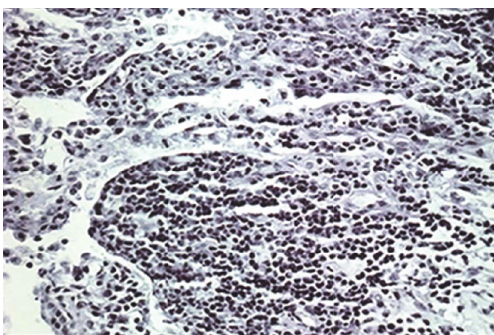
Figure 3: Photomicrograph demonstrating intra-alveolar myofi- broblastic proliferation (organising pneumonia-like